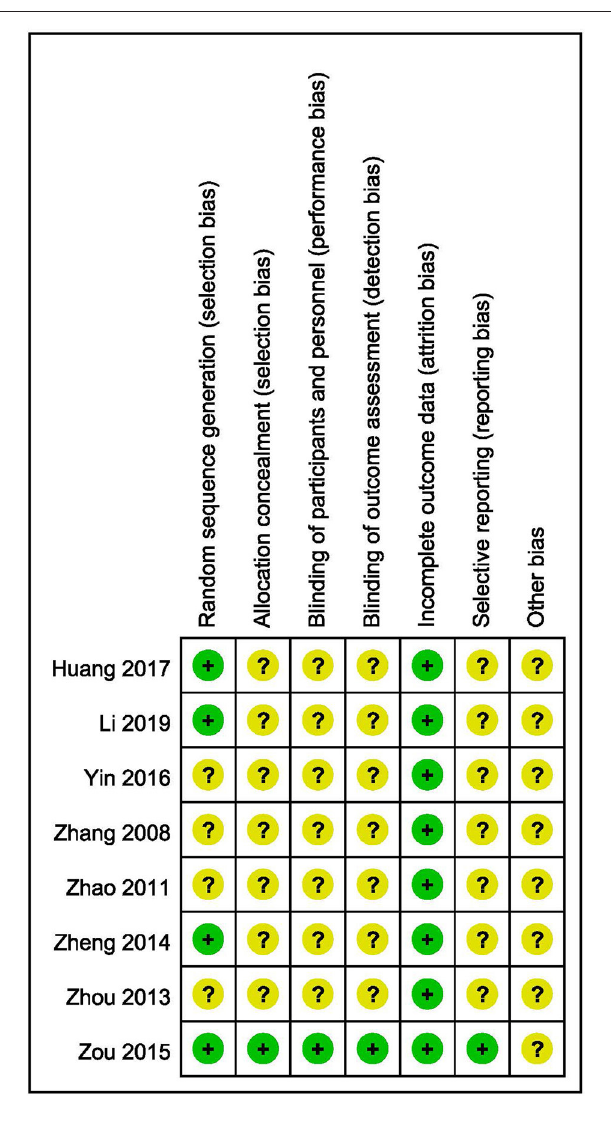
FIGURE 3 | Risk of bias